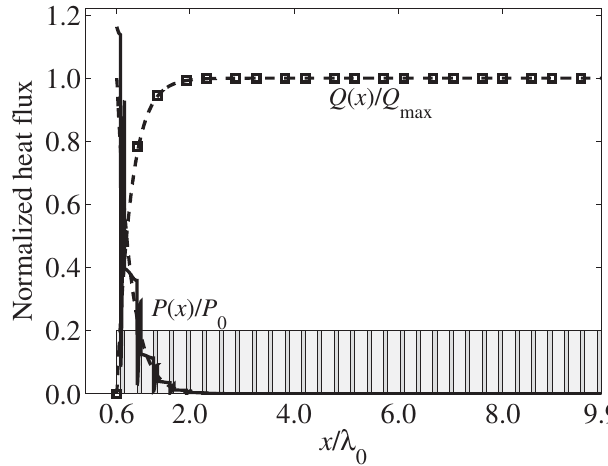
FIG. 8. Heat-flux profile in the silica-silicon structure, the parameters of which are given in Table II. The dashed line is the approximate curve, and the exact solution is indicated by square markers. The dissipated power profiles, approximate (dashed line) and exact (solid line), are also plotted. The two quantities are normalized by their maximal approximate